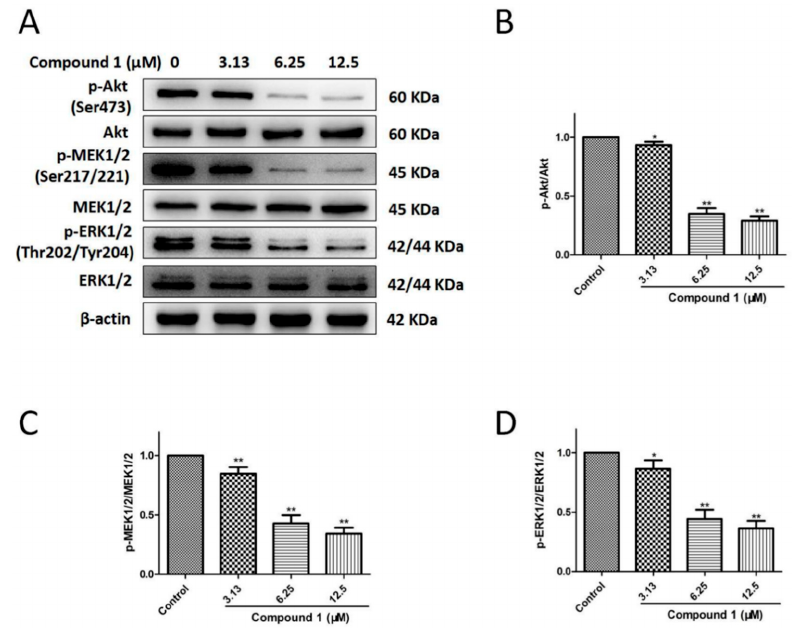
Figure 6. Effects of compound 1 on the Akt and MEK/ERK signaling pathways in A549 cells. ( A ) The phosphorylation and total protein levels of Akt, MEK1/2, and ERK1/2 were detected with an immunoblotting assay. ( B ) Compound 1 at concentrations of 3.13, 6.25, and 12.5 μ M notably de- creased the phosphorylation level of Akt. ( C ) Compound 1 at concentrations of 3.13, 6.25, and 12.5 μ M obviously reduced the phosphorylation level of MEK1/2. ( D ) Compound 1 at concentrations of 3.13, 6.25, and 12.5 μ M significantly reduced the phosphorylation level of ERK1/2. Data are shown as the mean ± SD ( n = 3). * p < 0.05 and ** p < 0.01 in comparison with the control